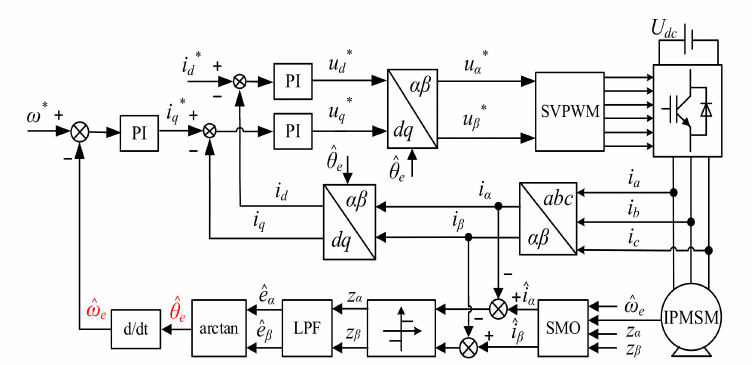
Figure 2. Traditional second-order sliding mode observer (SMO)